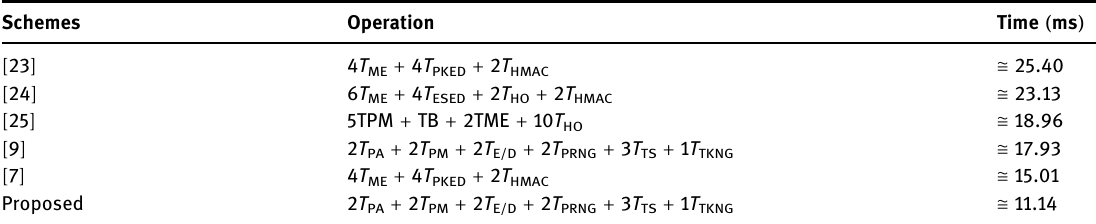
Table 5: Comparison of computation time with existing protocols Schemes Operation Time ( ms